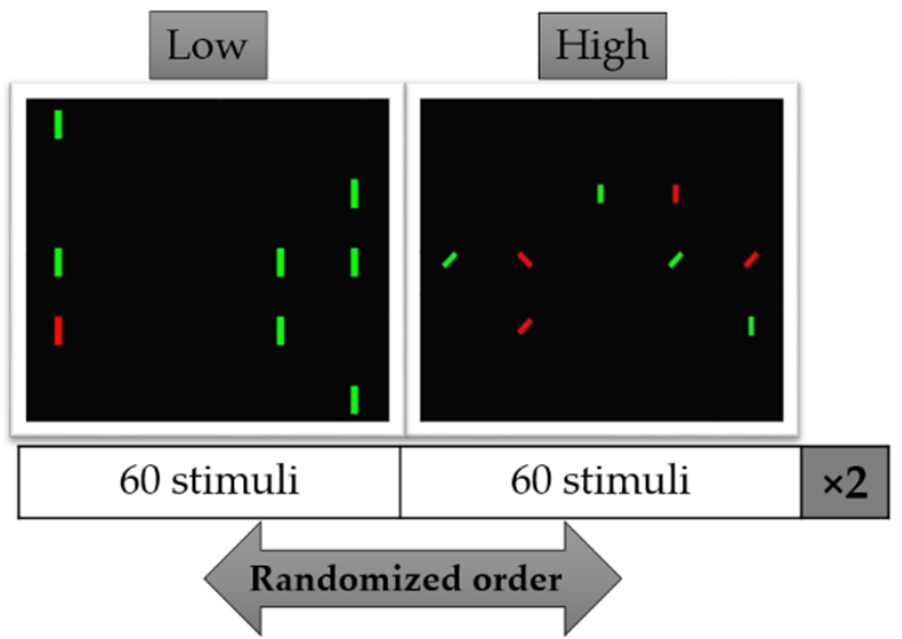
Figure 1. Conjunction Search Task. In both Low and High levels the target is a red vertical bar. In the Low condition, the distractors were green vertical rectangular bars. In the High condition, the distractors were vertical and 45° rotated green bars and 45° rotated red rectangular bars.